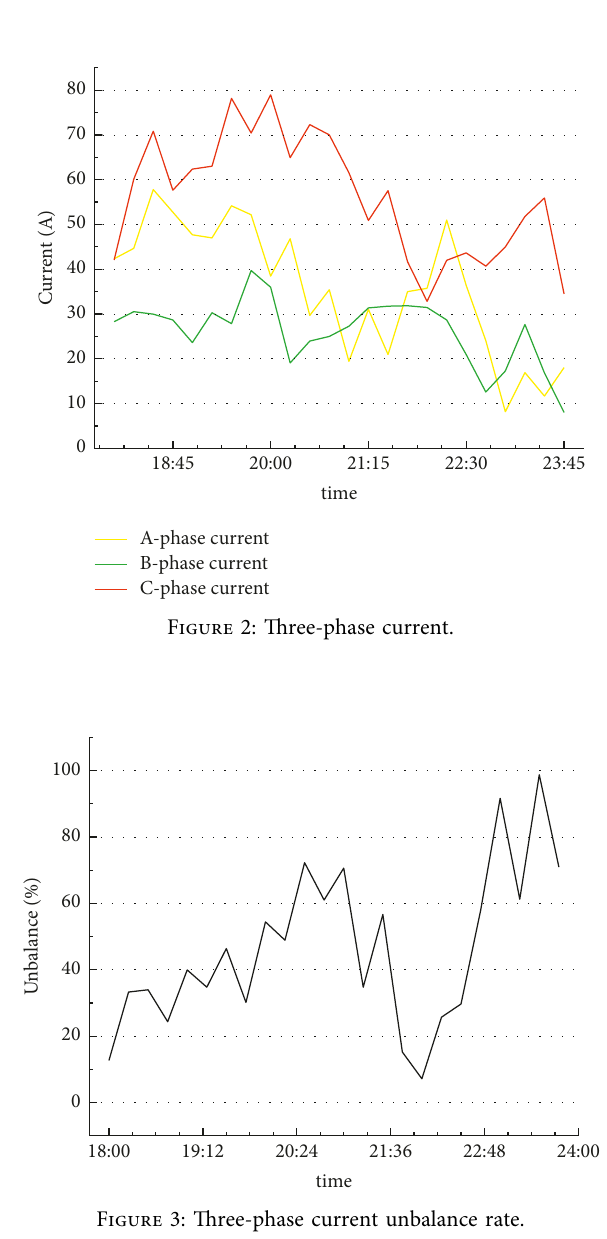
Figure 3: Three-phase current unbalance rate.